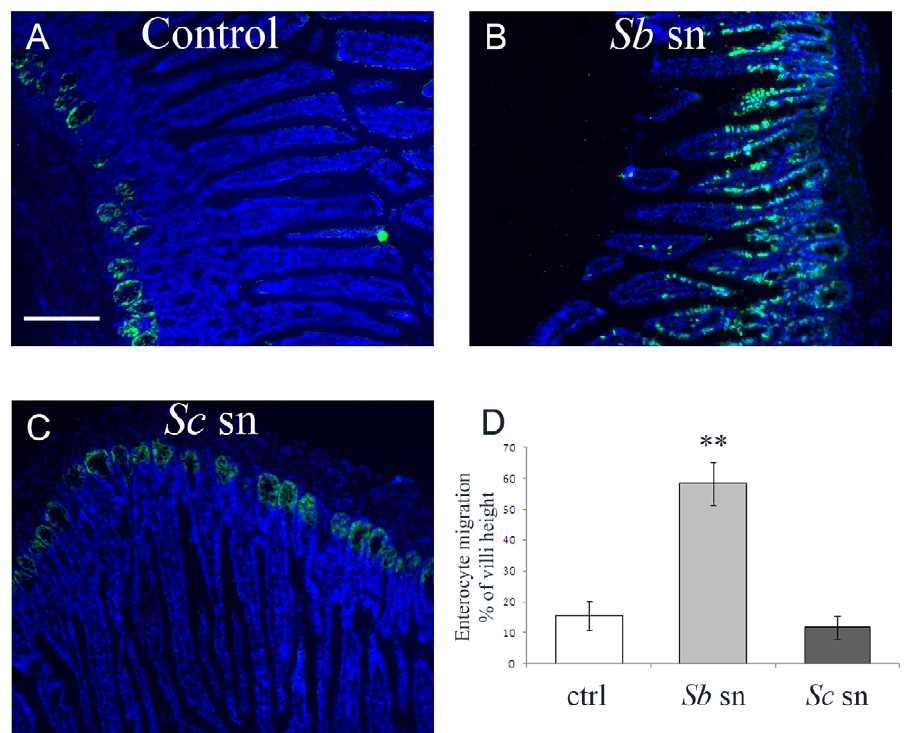
Figure 4. Sb supernatant but not Sc supernatant improves mouse enterocyte migration along the crypt-villus axis. Mice were daily force-fed for one week with unused culture medium for Sb (control), Sb supernatant ( Sb sn) or Sc supernatant ( Sc sn) then injected with BrdU 24 hours before sacrifice. Small intestinal tissues were processed for immunostaining. The BrdU-labeled enterocyte migration along the crypt-villus axis was traced on tissue sections by immunostaining with an anti-BrdU Ab ( A , B and C ) and quantitatively assessed ( D ) as described in Methods. (n=5). ** P , .01. Arrow: basal site of the enterocytes. Scale bar: 150 m m.